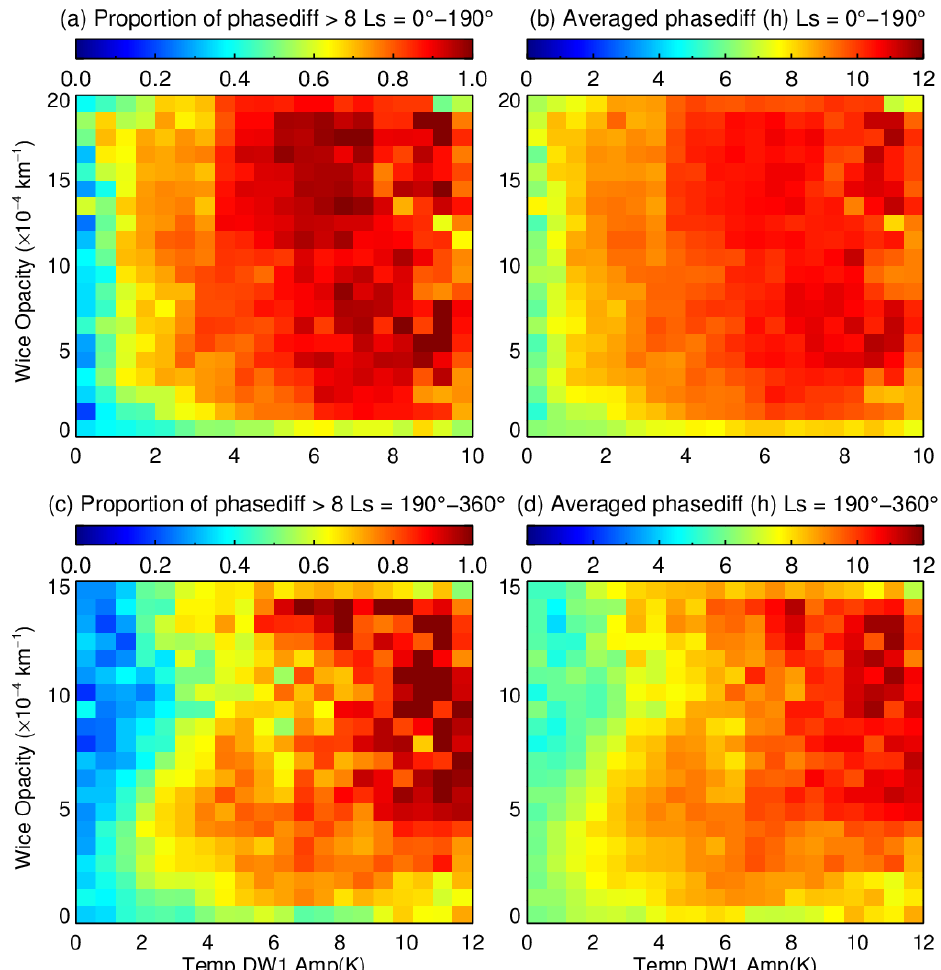
Figure 11. Occurrence frequency of the phase differences larger than 8 h (approximately anticorre- lated) with the temperature DW1 amplitude ( x -axis) and daily mean water ice abundance ( y -axis). The statistic includes data of all latitudes from 75°S to 75°N and pressure levels from 200 to 1 Pa during ( a ) Ls = 0°–190° and ( b ) Ls = 190°–360°. ( b , d ) The mean phase difference values corresponding to ( a , c ), respectively.